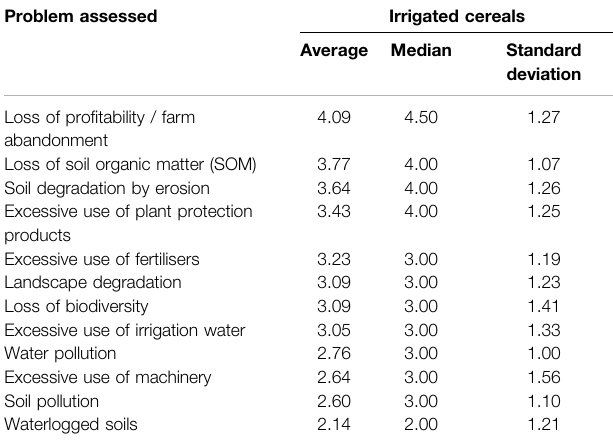
TABLE 2 | Stakeholders ’ qualitative subjective assessment and rating of the severity of agro-environmental problems in irrigated cereal-based